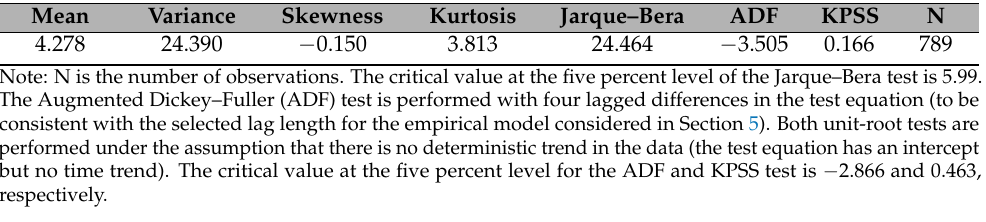
Figure 1. Housing–price return data. Note: Twelve–month change in percent on vertical axis. Table 1. Descriptive statistics of the returns, Jarque–Bera and unit root test